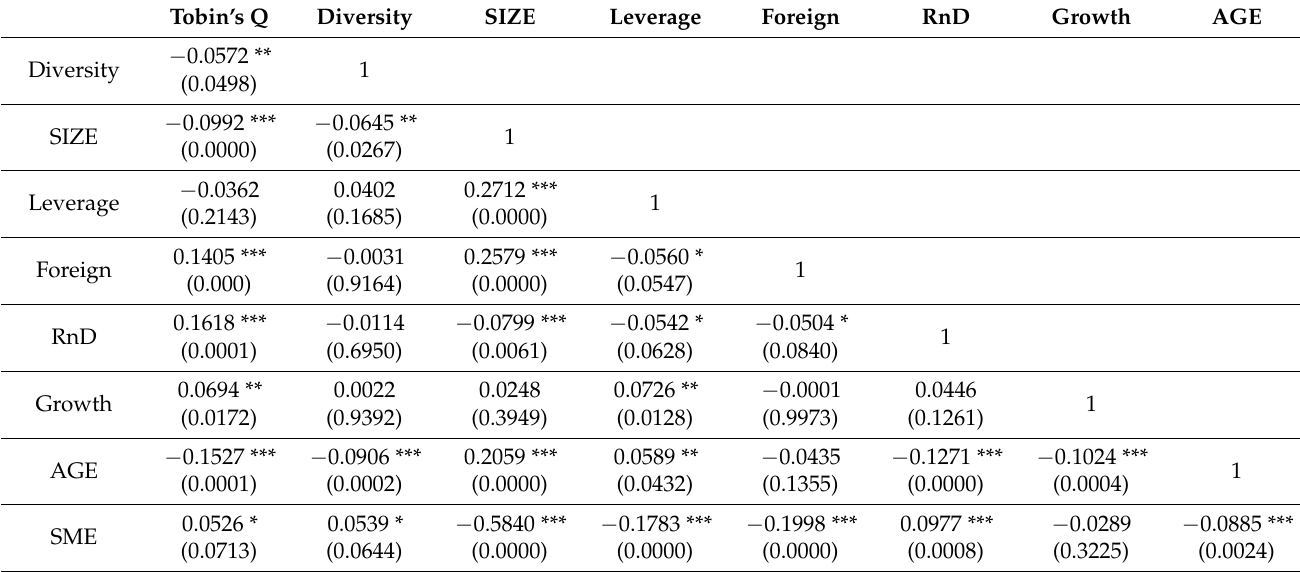
Table 2. Pearson’s Correlation of